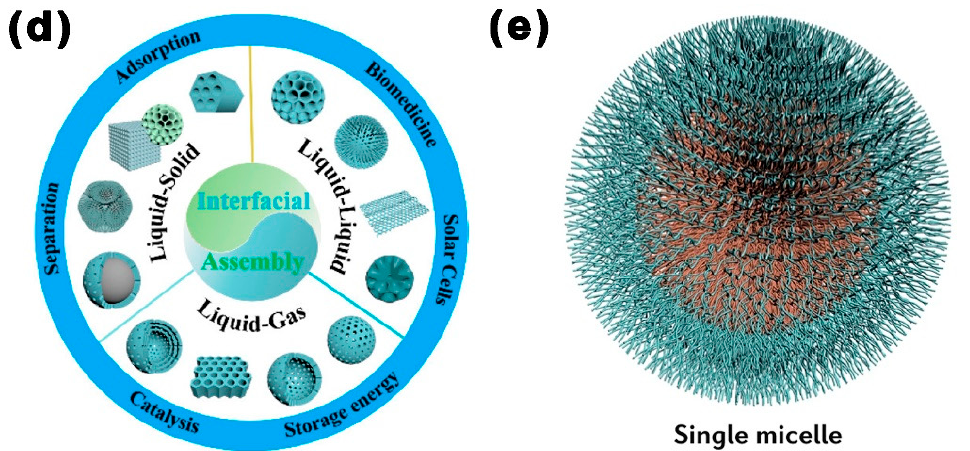
Figure 3. MCBM prepared by the soft template method. Schematic diagram and transmission electron microscopy (TEM) images of MCBM based on soft templates: ( a ) PPO–PEO–PPO for mesoporous carbon sample [52]. ( b ) F127 and P123 for nitrogen-doped OMCs [53]. ( c ) TEM images of meso-Fe-N-C for meso-Fe-N-C [55]. ( d ) Interfacial assembly mechanisms [56] and ( e ) single-micelle-directed synthesis method of mesoporous materials [57].